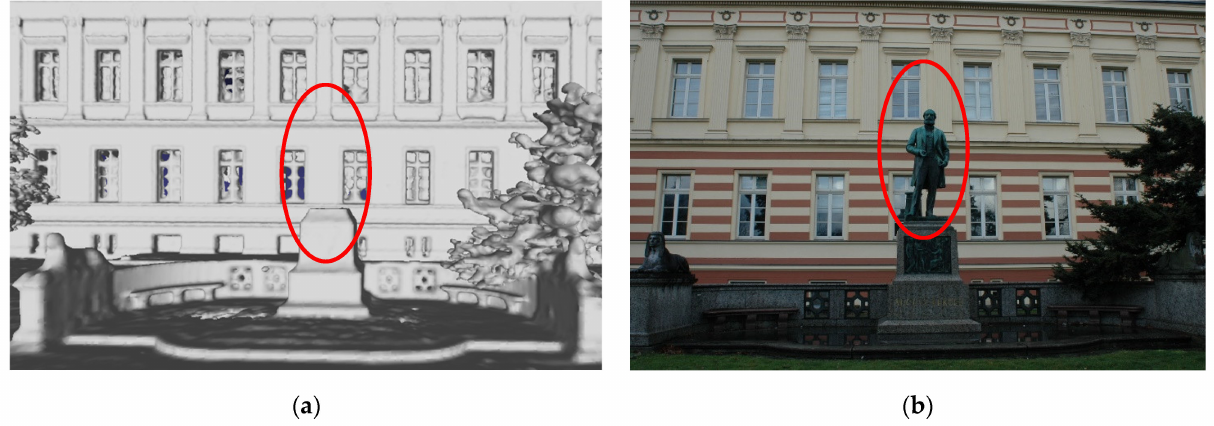
Figure 17. Finding changes in the environment based on an existing 3D model ( a ), and a sequence of (currently recorded) images ( b ).